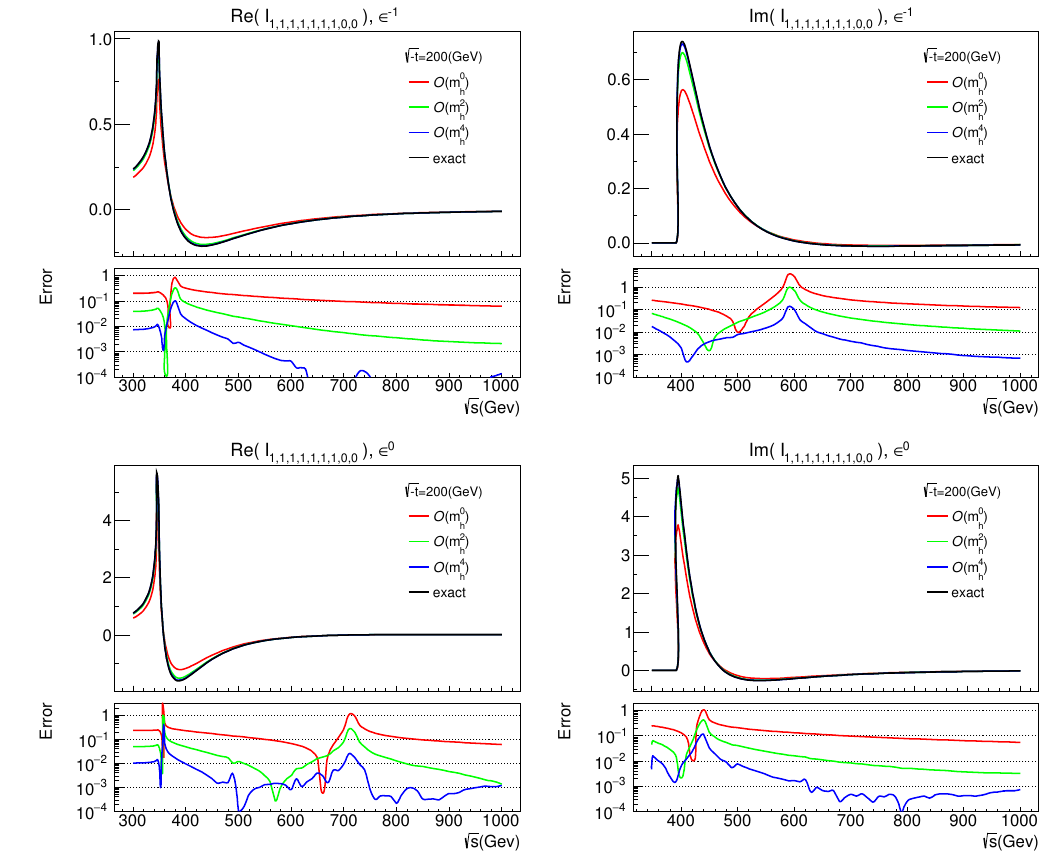
Figure 6 . The real part (left two plots) and the imaginary part (right two plots) of the order (cid:15) (cid:0) 1 and (cid:15) 0 coe(cid:14)cient for the two-loop integral I 1 ; 1 ; 1 ; 1 ; 1 ; 1 ; 1 ; 0 ; 0 in topology E as a function of t = (cid:0) (200 GeV) 2 . The integral has been multiplied by m 6